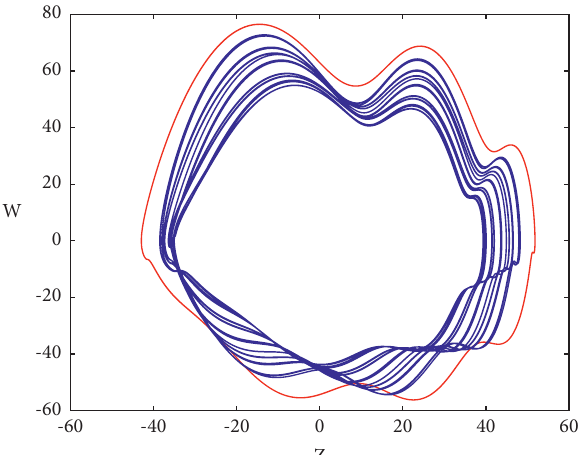
Figure 5: The system is multistable when a � 3 . 9 and b � 1. Initial conditions for red and blue colors are (− 2 . 77 , − 0 . 4021 , 6 . 2522 , − 0 . 0634 ) and (− 2 . 77 , − 0 . 4140 , − 1 . 5095 , − 0 . 3374 ) ,